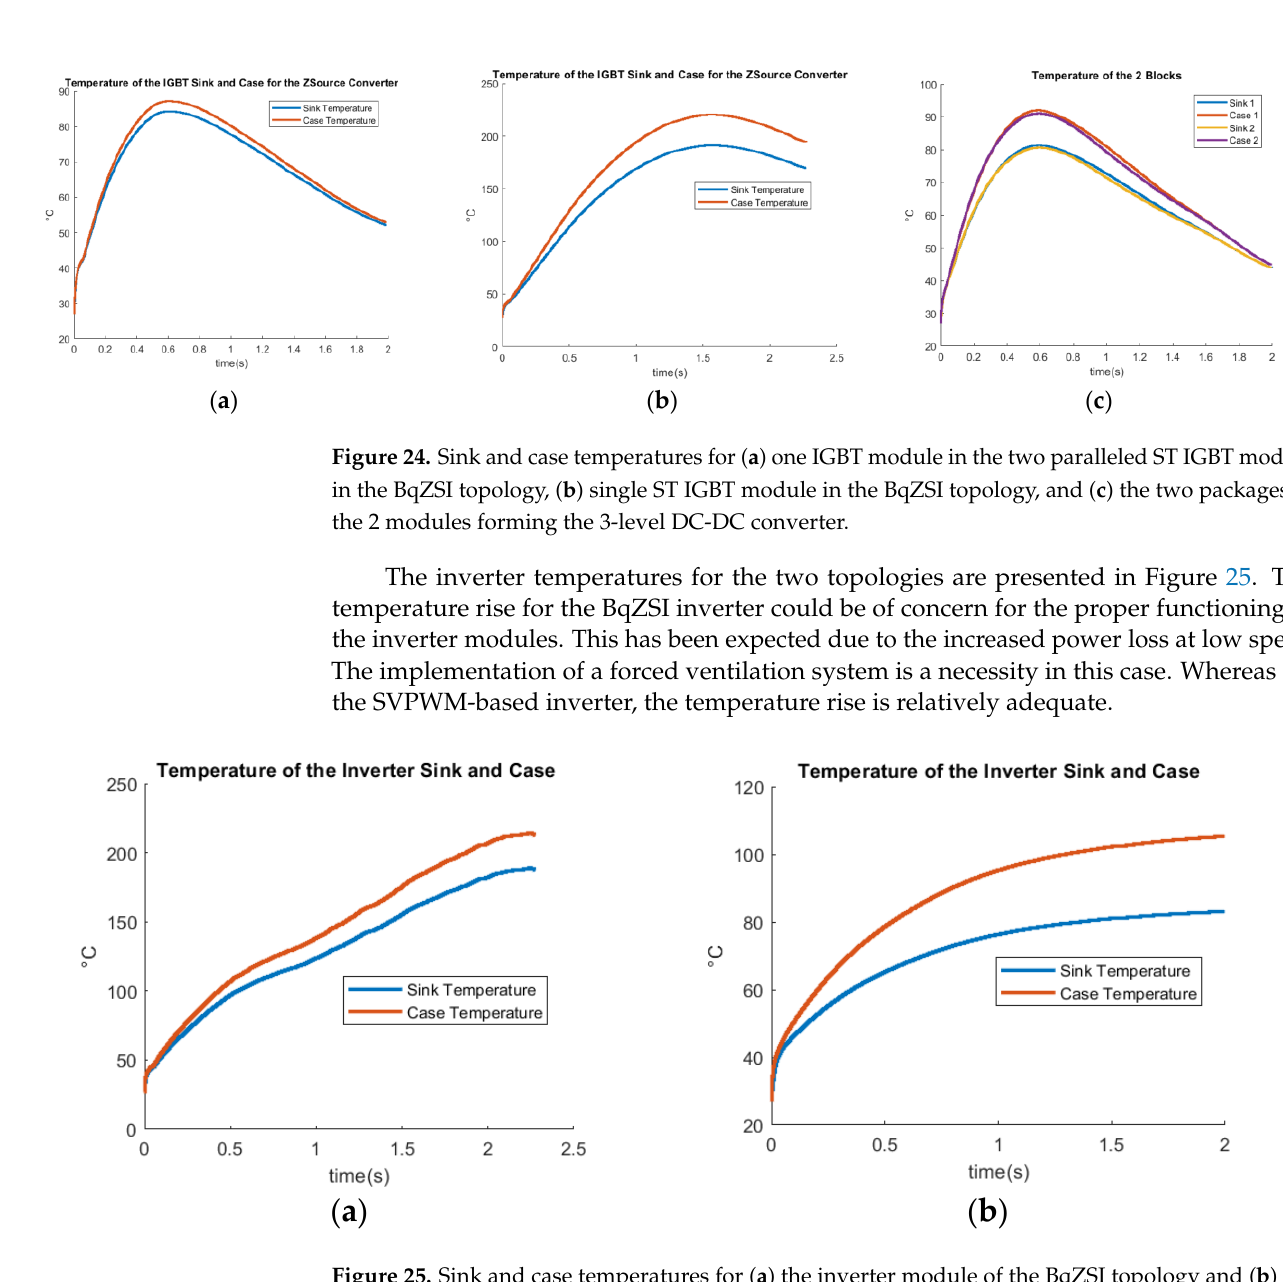
( c ) Figure 22. Overall efficiency of the powertrain conversion of ( a ) the two paralleled ST IGBT BqZSI topology, ( b ) single ST IGBT BqZSI topology, and ( c ) 3-level DC-DC/SVPWM. The voltage and the current in the 3-level converter are highly controlled values (a). Its efficiency curve will follow, inversely, the power curve in Figure 21c (also depending on the controlled current, Figure 19d). At the end, as the transferred power tends to zero, the efficiency tends to 100%. The speed trajectory of the vehicle is shown in Figure 23. The braking conditions are performed on a high friction coefficient road surface, according to the ECE R13 H regulation, with an anti-lock braking system (ABS) implemented in the braking control system. Figure 23. Speed trajectory (in m/s) for high friction coefficient road surface. 5.4.7. Temperature Evolution The temperatures of the DC/DC converters are presented in Figure 24. It is good to